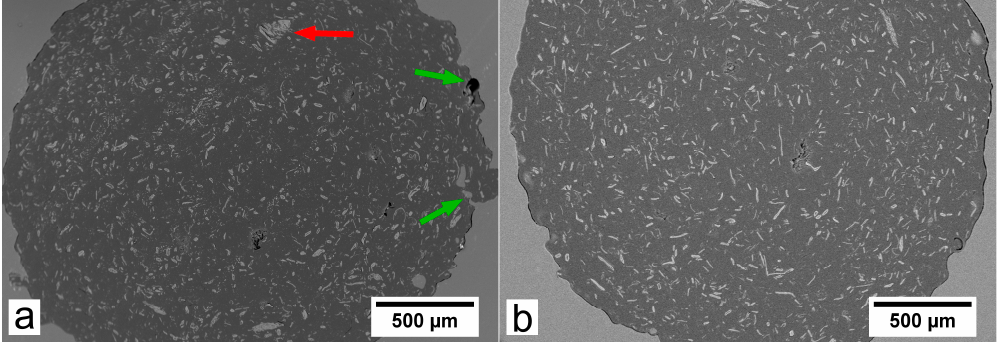
Figure 3. SEM cross-sectional image at 50× magnification. ( a ) B2-20T; ( b ) B2-20LGT. The red arrow indicates an agglomeration of fibers. The green arrows indicate surface pores probably caused by the relatively high surface roughness at this local area.